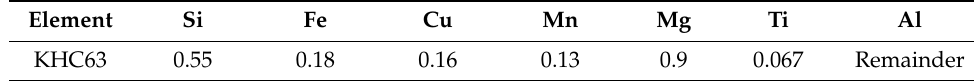
Table 1. Chemical composition of KHC63 alloy.